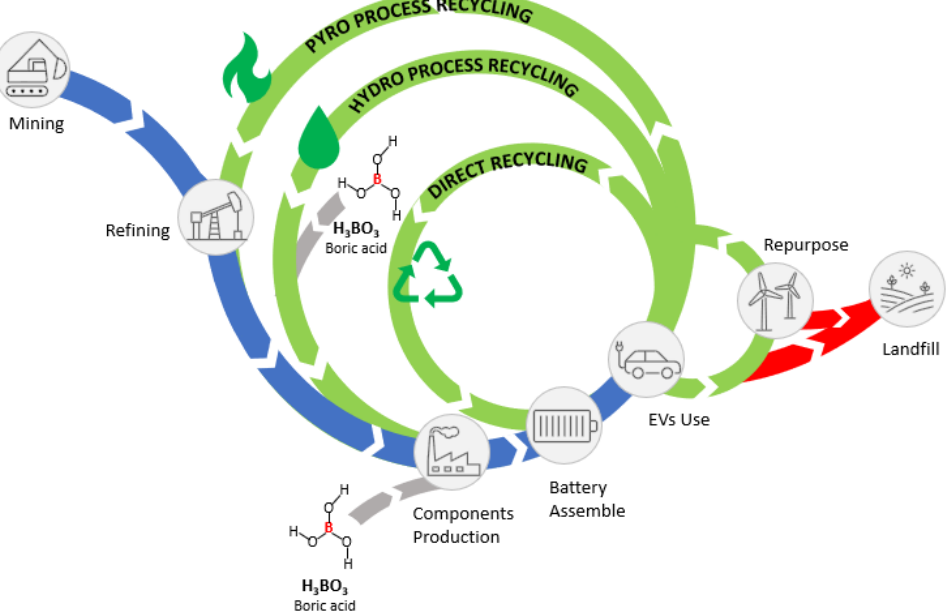
Figure 3. Introduction routesof boric acid in lithium battery lifecycles [49].